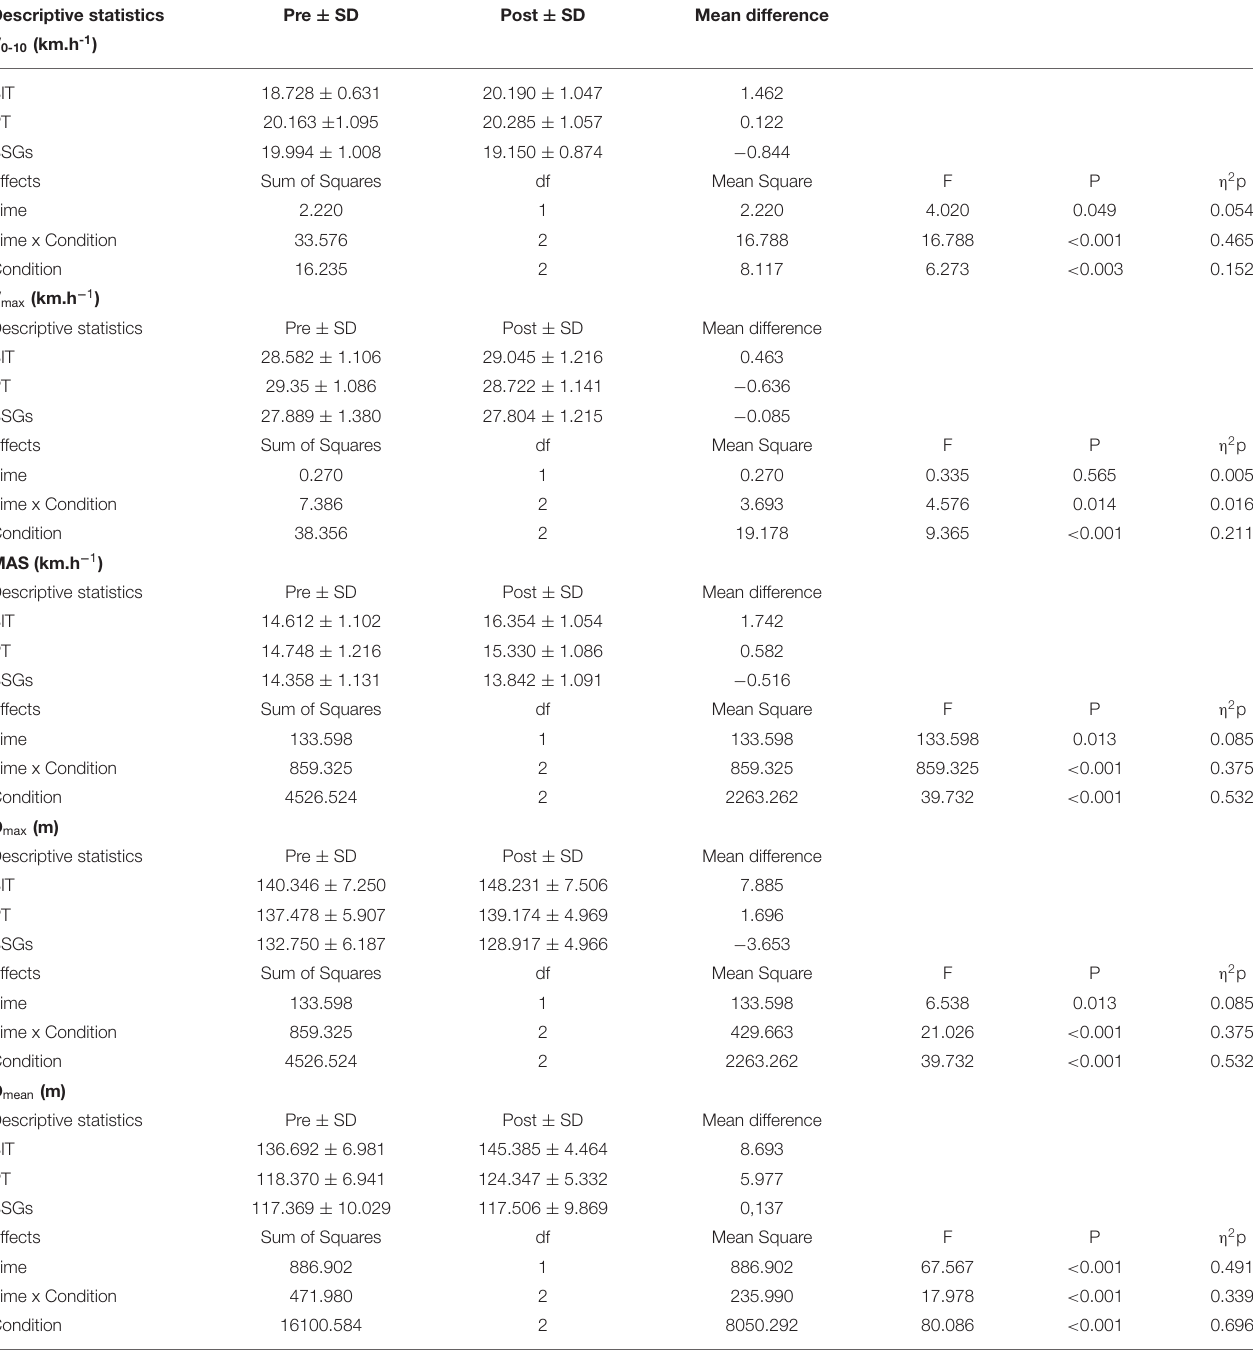
TABLE 5 | Raw data, descriptive statistics, and effects by